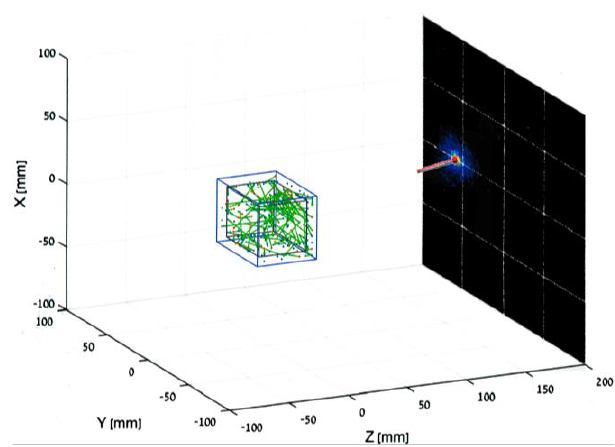
Fig. 4. Estimation of 662 keV 137 Cs isotope. The detector located at the origin (blue), with the directional vectors (green) shown inside the detector. The red arrow represents the location and direction of the estimated radioactive source. Colored estimation distribution is shown on the black